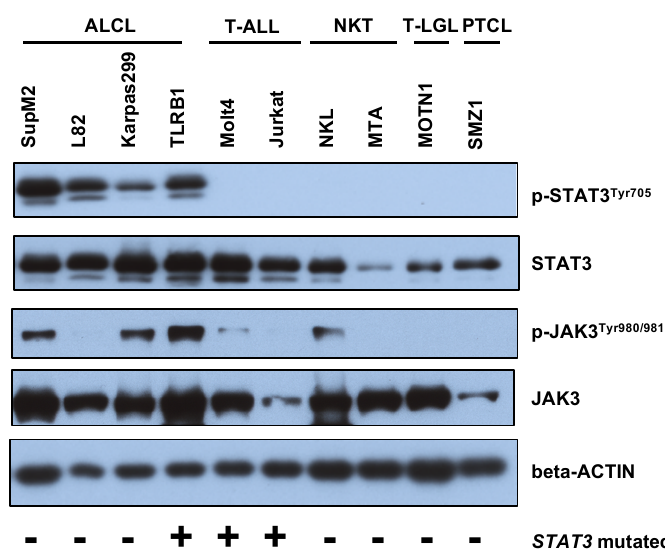
Figure 3. Western blot of p-STAT3 (Tyr705), STAT3, p-JAK3 (Tyr980 / 981), and JAK3 was characterized in T cell malignancy cell lines. Beta-ACTIN is used as a reference protein.